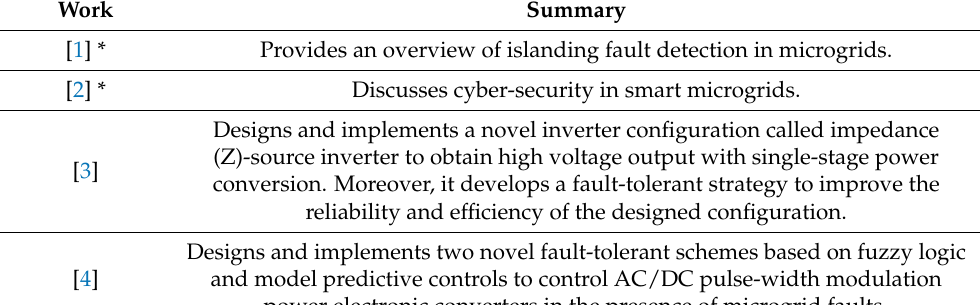
Table 1. Summary of the Special Issue articles.